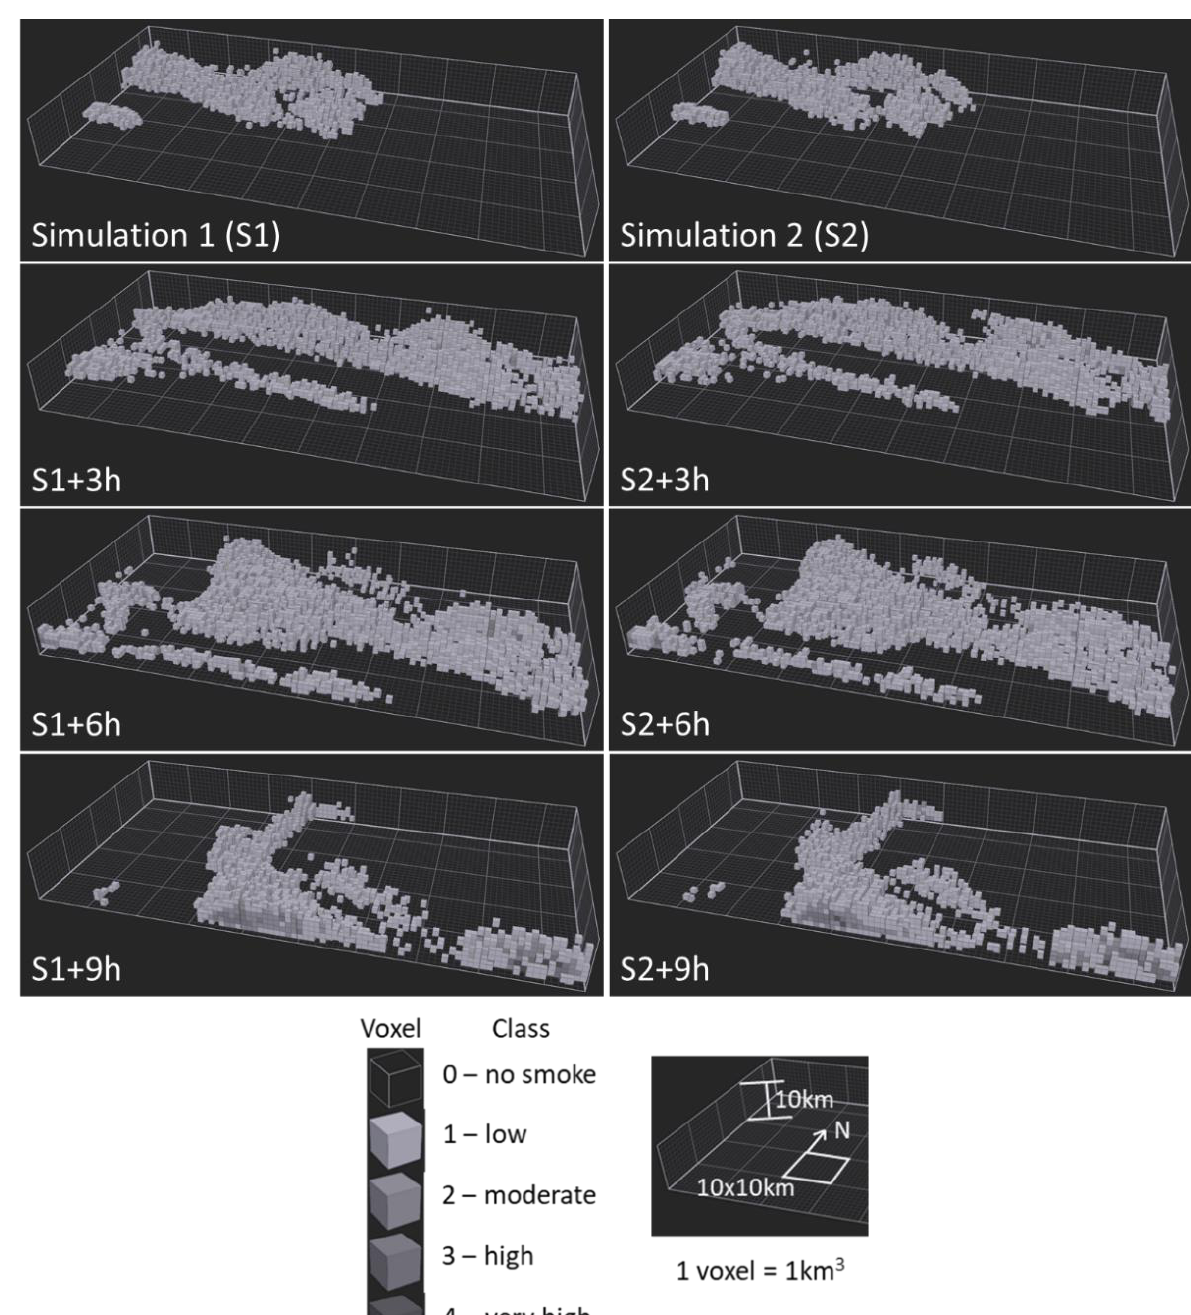
Figure 3 . Simulation outputs S1 and S2 at initial stage and after three hours, six hours, and nine hours of smoke